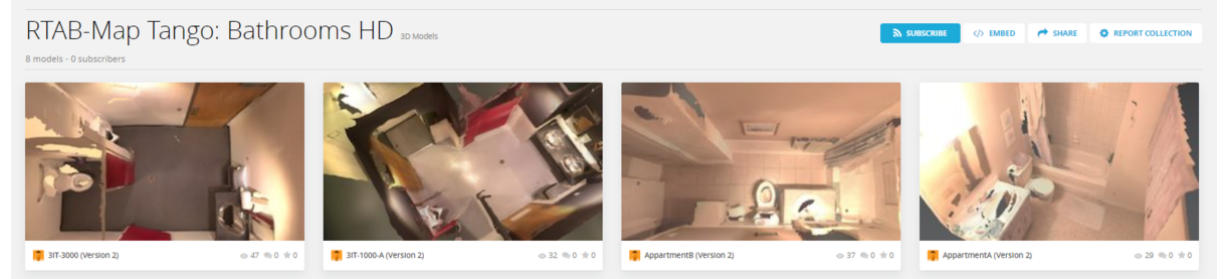
Figure 3. Excerpt from virtual repository on Sketchfab [28].